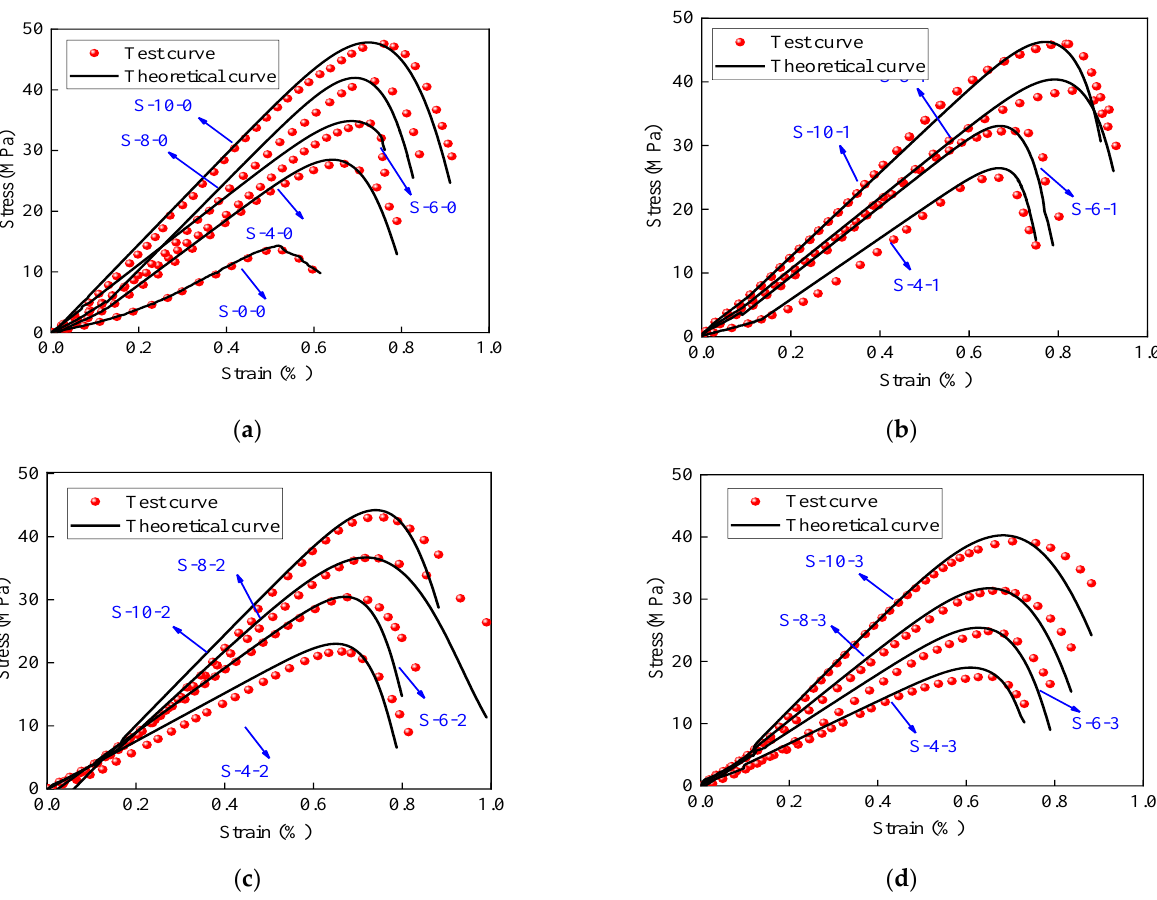
Figure 11. Comparison between experimental curve and theoretical curve. ( a ) Seepage pressure is 0 MPa, ( b ) seepage pressure is 1 MPa, ( c ) seepage pressure is 2 MPa, and ( d ) seepage pressure is 3